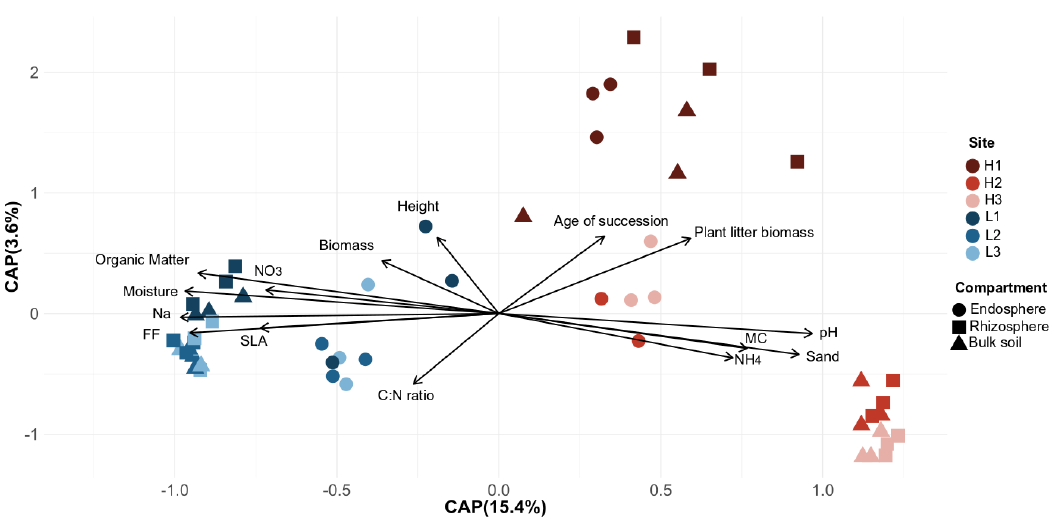
Figure 2. Partial distance-based redundancy analysis (db-RDA) for the bacterial communities associated with E. atherica traits and environmental variables based on the Bray–Curtis dissimilarity. SLA, specific leaf area; Biomass, aboveground biomass; MC, Mycorrhizal colonization. C:N ratio, soil total carbon to total nitrogen ratio. FF, Flooding frequency. Percentage of variance explained by each axis is indicated in parentheses. Symbol color indicate sites, symbols in red shades are found at high elevation and blue shade at low elevation.